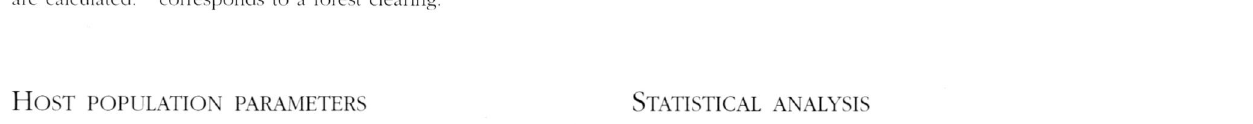
Table I. - Distribution of the 214 trap lines by habitat and by season. Arrows design the habitats in which the rodent ralative abundances are calculated. * corresponds to a forest clearing.